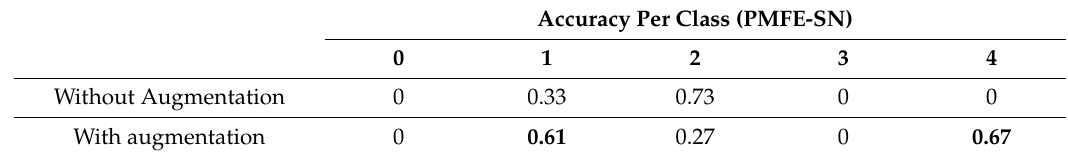
Table 6. Comparison of per-class accuracy of PMFE-SN with and without augmentation on leave one cross-out testing.